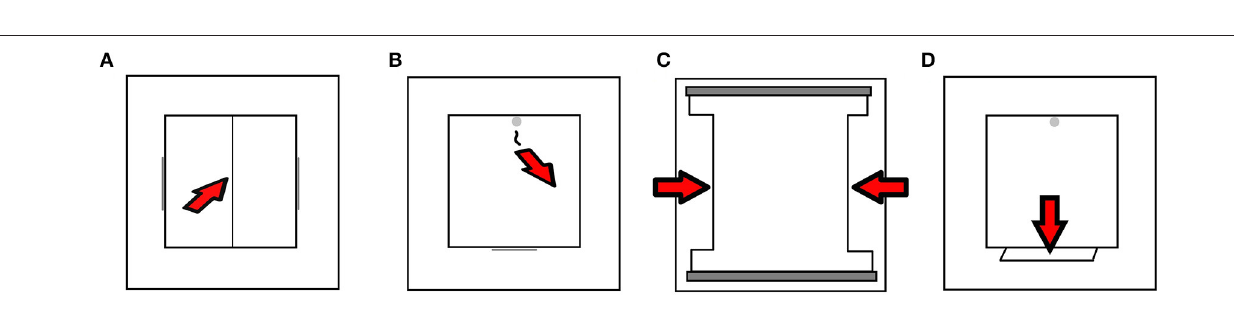
FIGURE 2 | The four test panels that can be inserted in the frames of the TBA: (A) swing panel, (B) string panel (invisible magnet behind door in light gray), (C) slide panel, (D) step panel (invisible magnet behind door in light gray). Arrows illustrate the